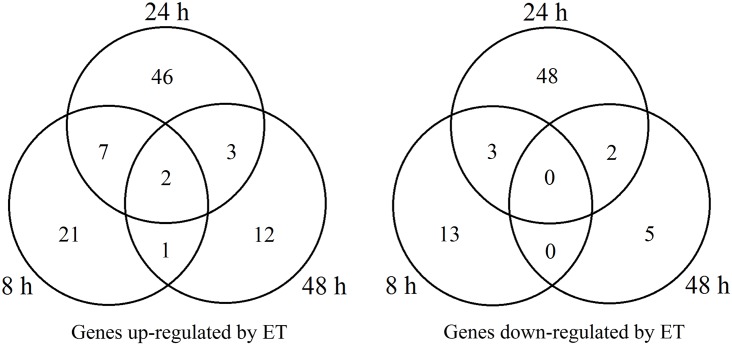
Venn diagram analysis for the ET-responsive genes under the different times of ET treatment.Overlapping circles visually represented the commonalities among sets of information. The number of differentially expressed genes shared by different time-points (8, 24 and 48 h) under ET treatment was displayed in the overlapping circles.